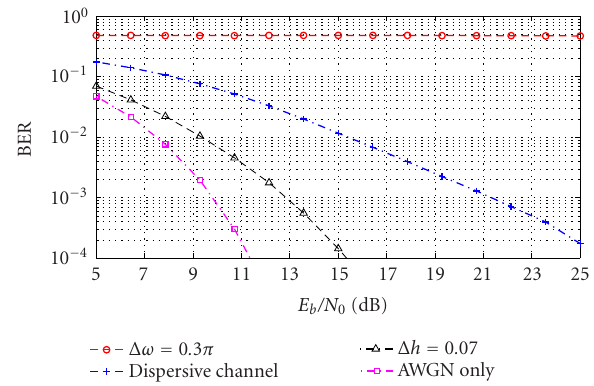
Figure 10: BER performance under isolated disturbances of a dis- persive channel, a carrier frequency o ff set of ∆Ω = 0 . 3 π , and a modulation index o ff set ∆ h = 0 . 07, with parameters K = 9, N = 2, K BT = 0 . 5, h = 0 .